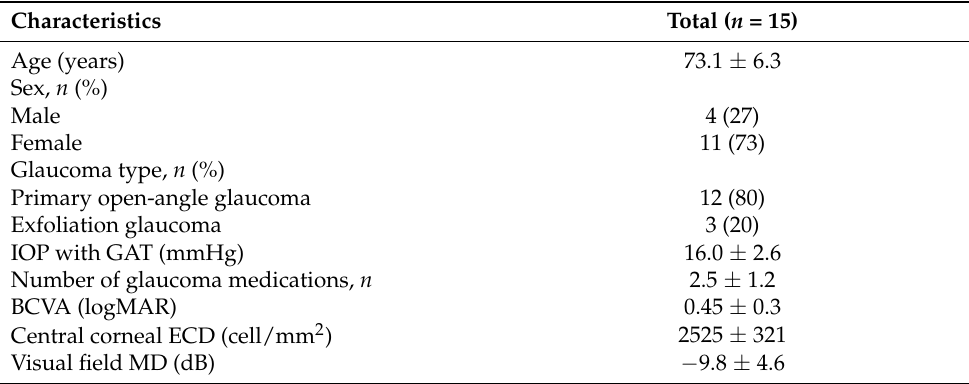
Table 1. Patient